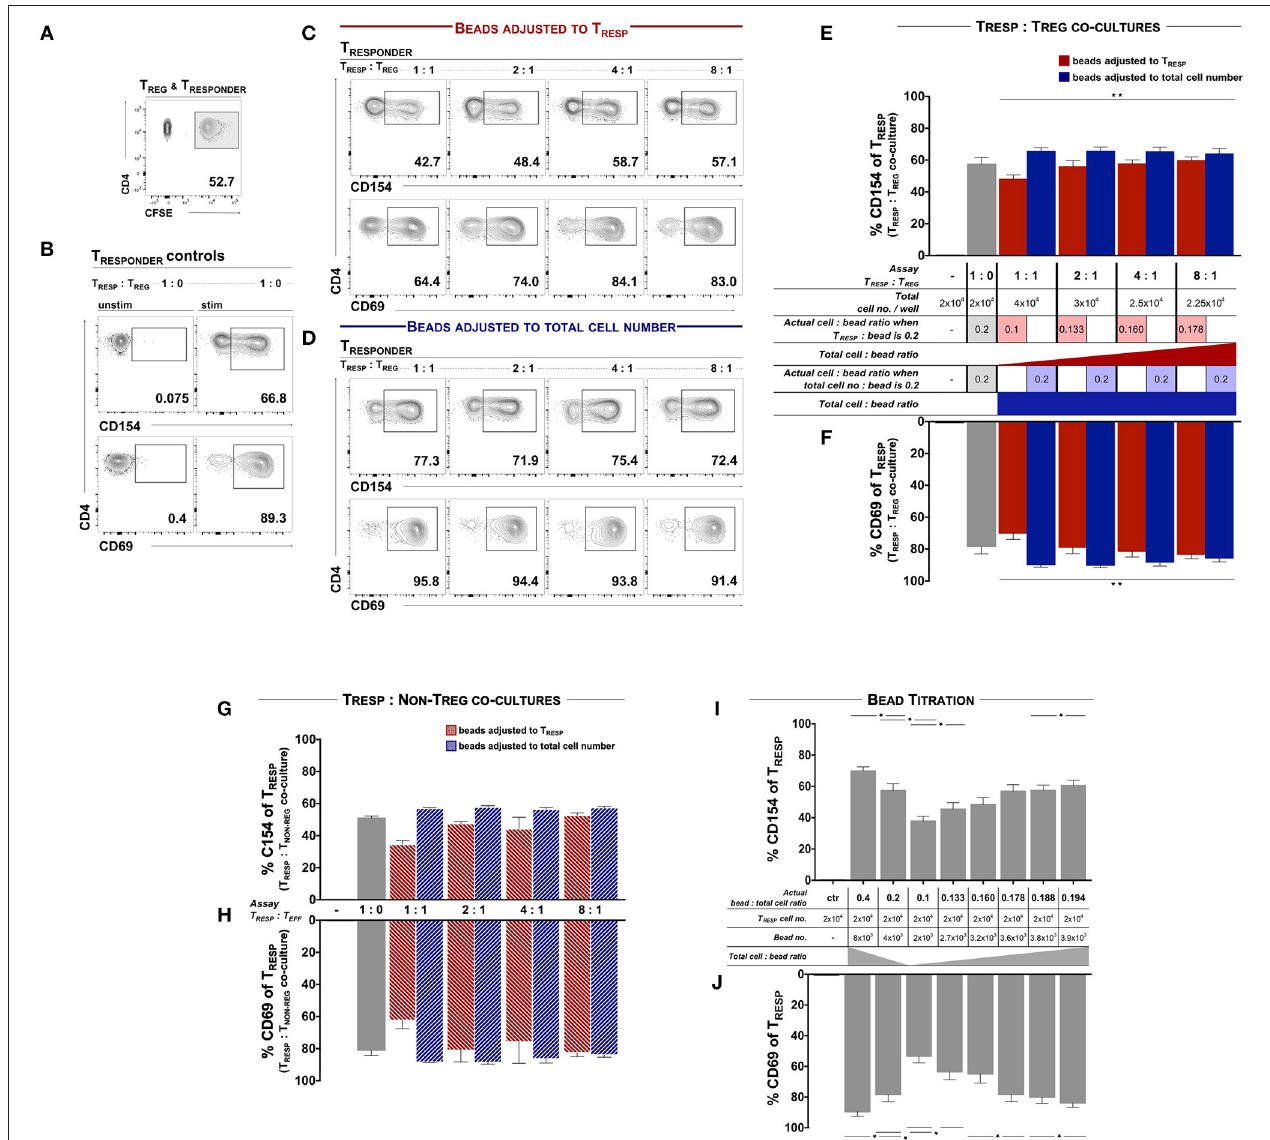
FIGURE 1 | T CELL early activation marker expression is dependent of TCR engagement and cannot be used for T REG functional evaluation. FACSorted CD4 + CD25 − T RESP with and without autologous T REG co-culture were stimulated with anti-CD3/CD28-coated microbeads and analyzed for early activation marker expression. (A) For precise T RESP /T REG discrimination, T RESP were labeled with CFDA-SE (CFSE). (B) Representative plots of CD154 and CD69 expression on unstimulated and stimulated T RESP cultured without T REG . (C) Representative plots of CD154 and CD69 expression of T RESP co-cultured with T REG at different T RESP :T REG ratios and stimulated with anti-CD3/CD28-coated microbeads adjusted to T RESP . (D) Representative plots of CD154 and CD69 expression of T RESP co-cultured with T REG at different T RESP :T REG ratios and stimulated with anti-CD3/CD28-coated microbeads adjusted to total cell number. (E,F) Quantified data from (C,D) , respectively. CD154 and CD69 of CFSE + T RESP co-cultured with FACSorted T REG at different T RESP :T REG ratios and stimulated with anti-CD3/CD28-coated microbeads adjusted to T RESP (red columns) and to total cell numbers (blue columns). For clarification, the table summarizes the experimental setups. n = 7. Non-parametric rank-based ANOVA-type statistic ** p < 0.001 (CD154: p = 1.90E-06, CD69: p = 5.527256E-16). (G) Expression of CD154 and (H) expression of CD69 of CFSE + T RESP co-cultured with FACSorted T NON − TREG at different T RESP :T REG ratios and stimulated with anti-CD3/CD28-coated microbeads adjusted to T RESP (red columns) and to total cell numbers (blue columns). n = 3. (I) Expression of CD154 and (J) expression of CD69 of CFSE + T RESP after different anti-CD3/CD28-coated microbead:T RESP ratio stimulation. For clarification, the table summarizes the experimental setups. n = 7. * p < 0.05, Wilcoxon matched-pairs signed rank test. T RESP :T REG /T NON − TREG co-cultures (E,F) and corresponding bead titration (I,J) experiments were performed simultaneously using the same donor cells. Median data of independent experiments are shown and error bars represent